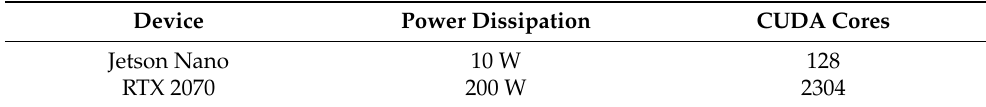
Table 4. Hardware performance.